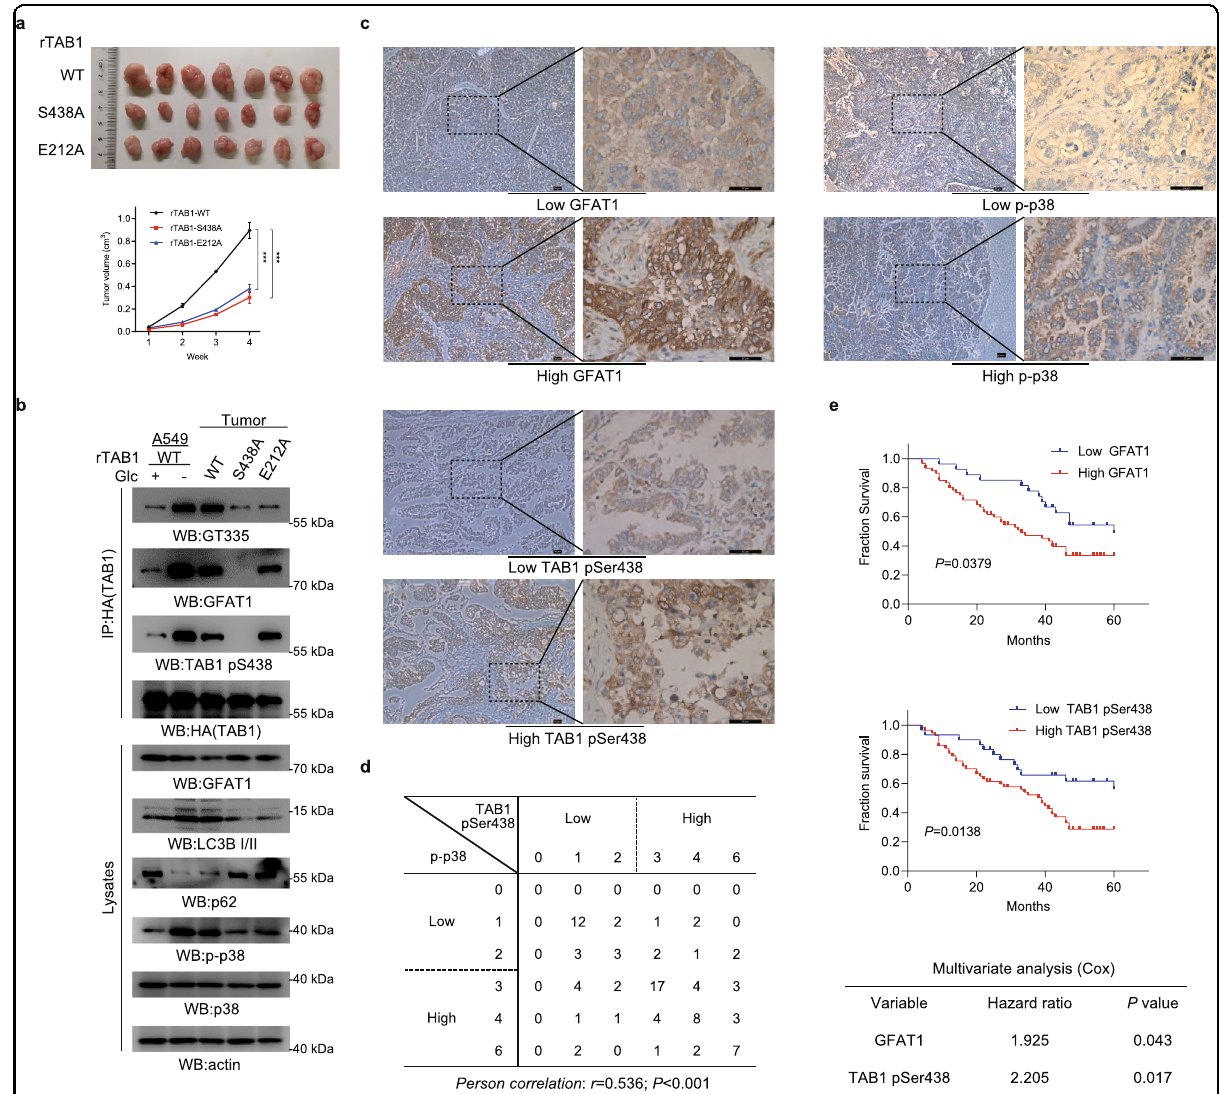
Fig. 6 GFAT1-TAB1-TTLL5 axis promotes tumorigenesis and is related to poor prognosis. a Expression of rTAB1-S438A or rTAB1-E212A suppressed tumorigenesis. A total of 5 × 10 6 A549 cells with TAB1 depletion and reconstituted expression of the WT rTAB1, rTAB1-S438A or rTAB1- E212A were subcutaneously injected into athymic nude mice. Representative tumour xenografts are shown (upper panel). Tumor volumes were measured by using length “ a ” and width “ b ” and calculated using the following equation: V = ab 2 /2. b Expression of rTAB1-S438A or rTAB1-E212A suppressed TAB1-p38-autophagy axis. Immunoprecipitated HA-rTAB1 from lysates of A549 cells that were cultured for 8 h under glucose deprivation and 7 pooled tumor tissues (as indicated in a ) was subjected to immunoblotting analyses using the indicated antibodies. c Immunohistochemical staining was performed on 87 human lung adenocarcinoma specimens using the indicated antibodies. Representative images are shown. Scale bars, 50 µm. d Semi-quantitative scoring and correlation analysis indicating the correlation between p-p38 and TAB1 pSer438 (Person correlation test; r = 0.536, P < 0.001). e The survival durations for 87 patients with low (0 – 2 staining scores, blue curve) versus high (3 – 6 staining scores, red curve) GFAT1 (low, n = 27 patients; high, n = 60 patients) and with low (0 – 2 staining scores, blue curve) versus high (3 – 6 staining scores, red curve) TAB1 Ser438 phosphorylation (low, n = 30 patients; high, n = 57 patients) were compared. The Kaplan – Meier method and log-rank tests indicate the signi fi cance level of the association of GFAT1 ( P = 0.0379) with patient survival and the signi fi cance level of the association of TAB1 Ser438 phosphorylation ( P = 0.0138) with patient survival. The table shows the Cox multivariate analysis after adjustment for patient sex and age, indicating the signi fi cance level of the association of GFAT1 ( P = 0.043, HR = 1.925) with patient survival and the signi fi cance level of the association of TAB1 Ser438 phosphorylation ( P = 0.017, HR = 2.205) with patient survival. In a , the values are presented as means ± SEM, n = 7; *** P < 0.001, Student ’ s t -test,